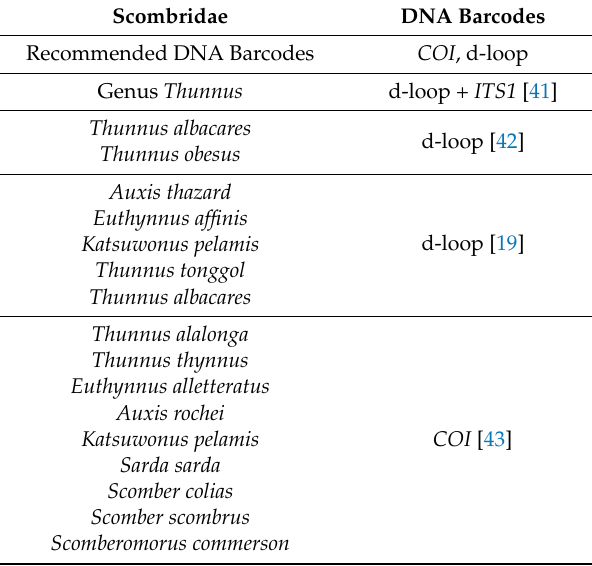
Table 6. Commonly used DNA barcodes in